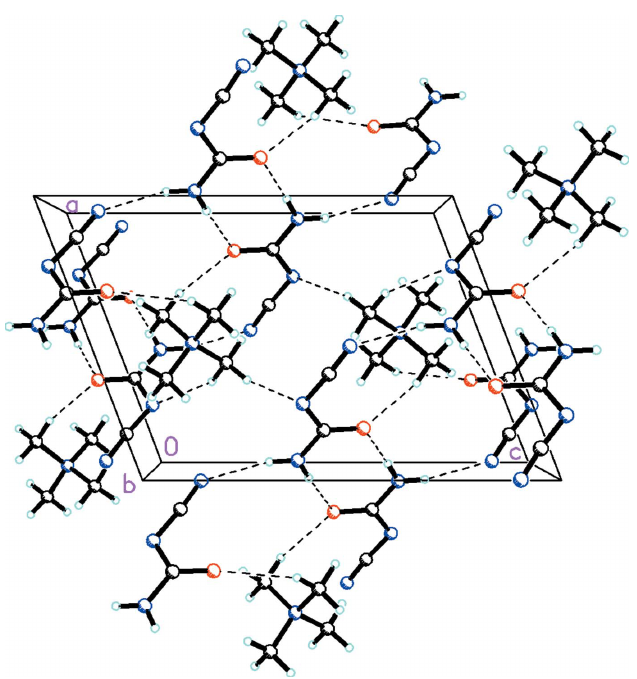
Figure 2 Diagram showing the packing of the cations and anions in the unit cell, which involves N—H (cid:2)(cid:2)(cid:2) O hydrogen bonds between anions characterized by an R 2 (8) motif as well as N—H (cid:2)(cid:2)(cid:2) O hydrogen bonds between anions 2 and C—H (cid:2)(cid:2)(cid:2) O interactions between both cations and anions forming an R 3 (14) pattern (all interactions shown with dashed lines). 3